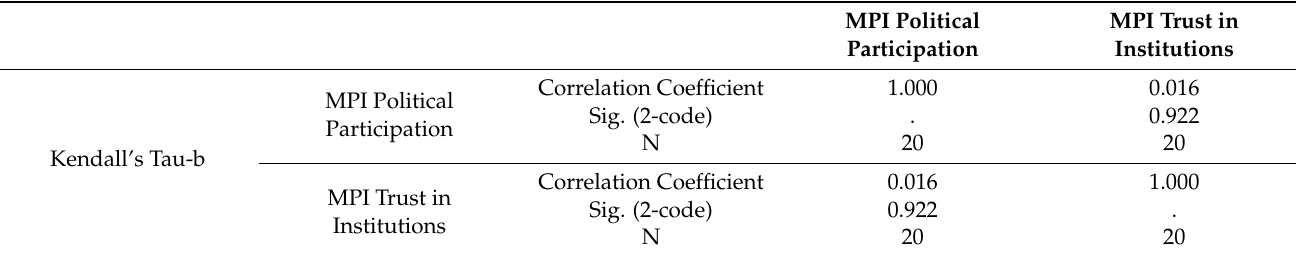
Table 7. Correlation between Political Participation and Trust in